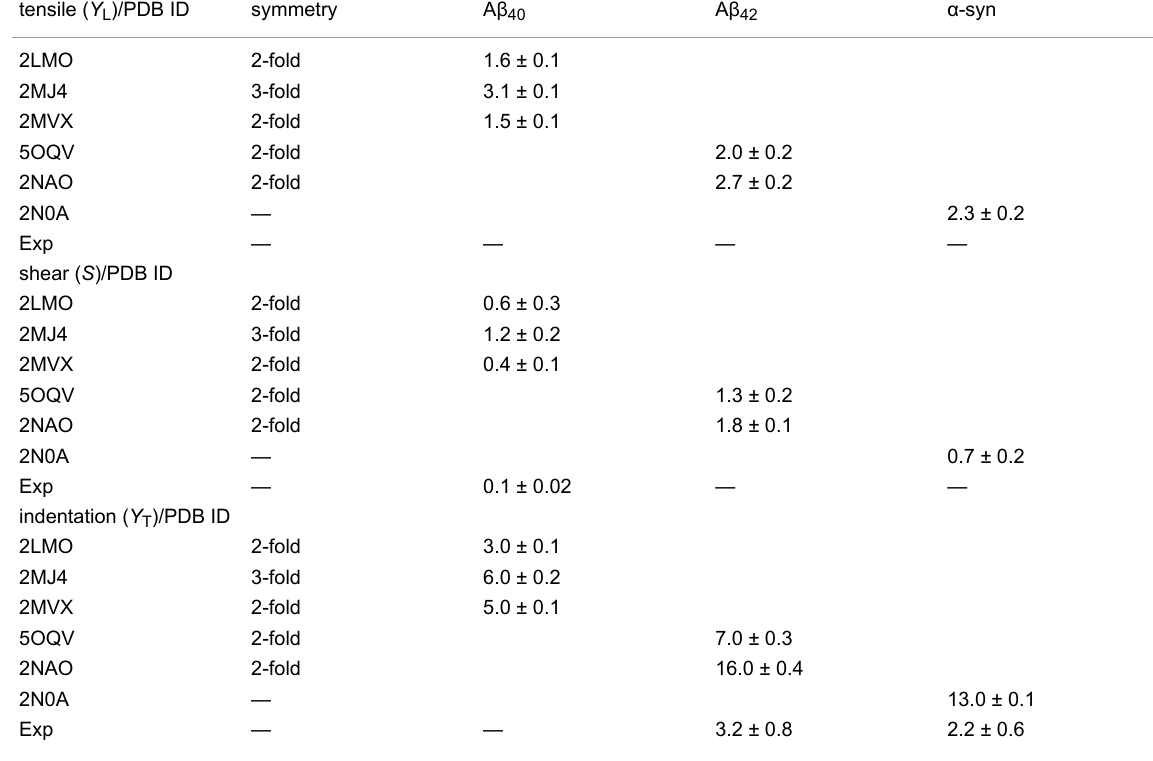
Table 2: The elastic moduli in GPa for the A β 40 , A β 42 and α -syn from experiment and our CG model. The structural symmetry of β -amyloid (if speci- fied in the literature) is given next to the PDB entries. The experimental results regarding indentation for A β 42 and α -syn have been taken from [30]. The experimental values for the shear modulus ( S ) for β -amyloids have been taken from [62], while the experimental values of S and Y L for α -syn are currently unknown.